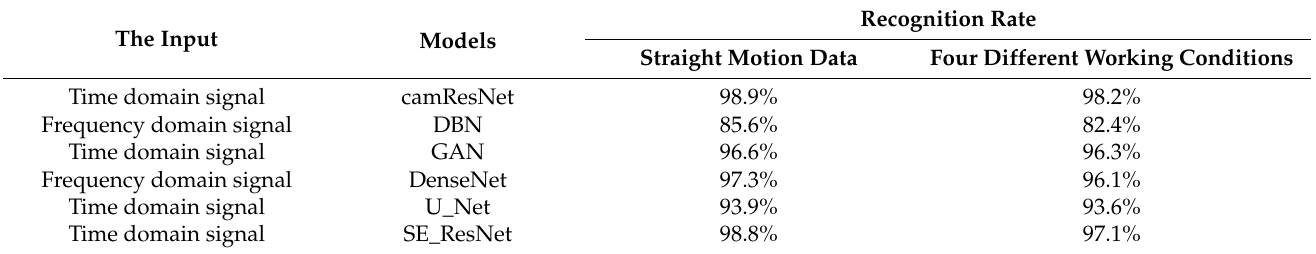
Table 3. Recognition rate of proposed model and compared models with straight motion data and four different working